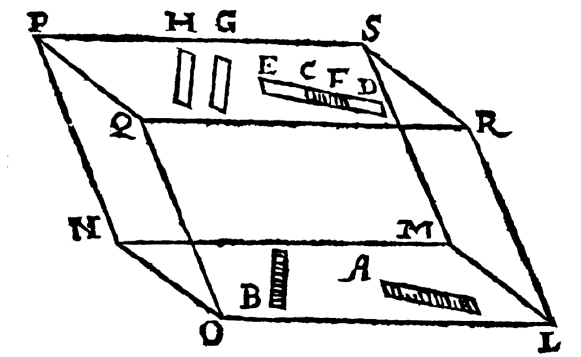
Figure 4. Birefringence in calcite observed by R. Bartholin. H and G, EC and FD are the double refracted images of B and A, in the order. (From reference 8, p.